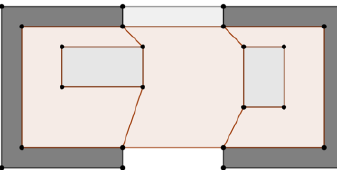
Figure 5. Partitioning space to account for holes in the space. The floor space has been partitioned into three contiguous spaces to manage the holes.